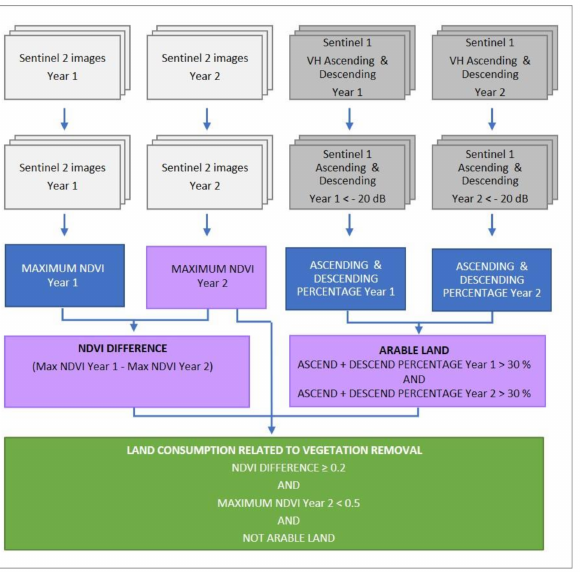
Figure 2. Workflow of the methodology of land consumption related to vegetation removal with arable land